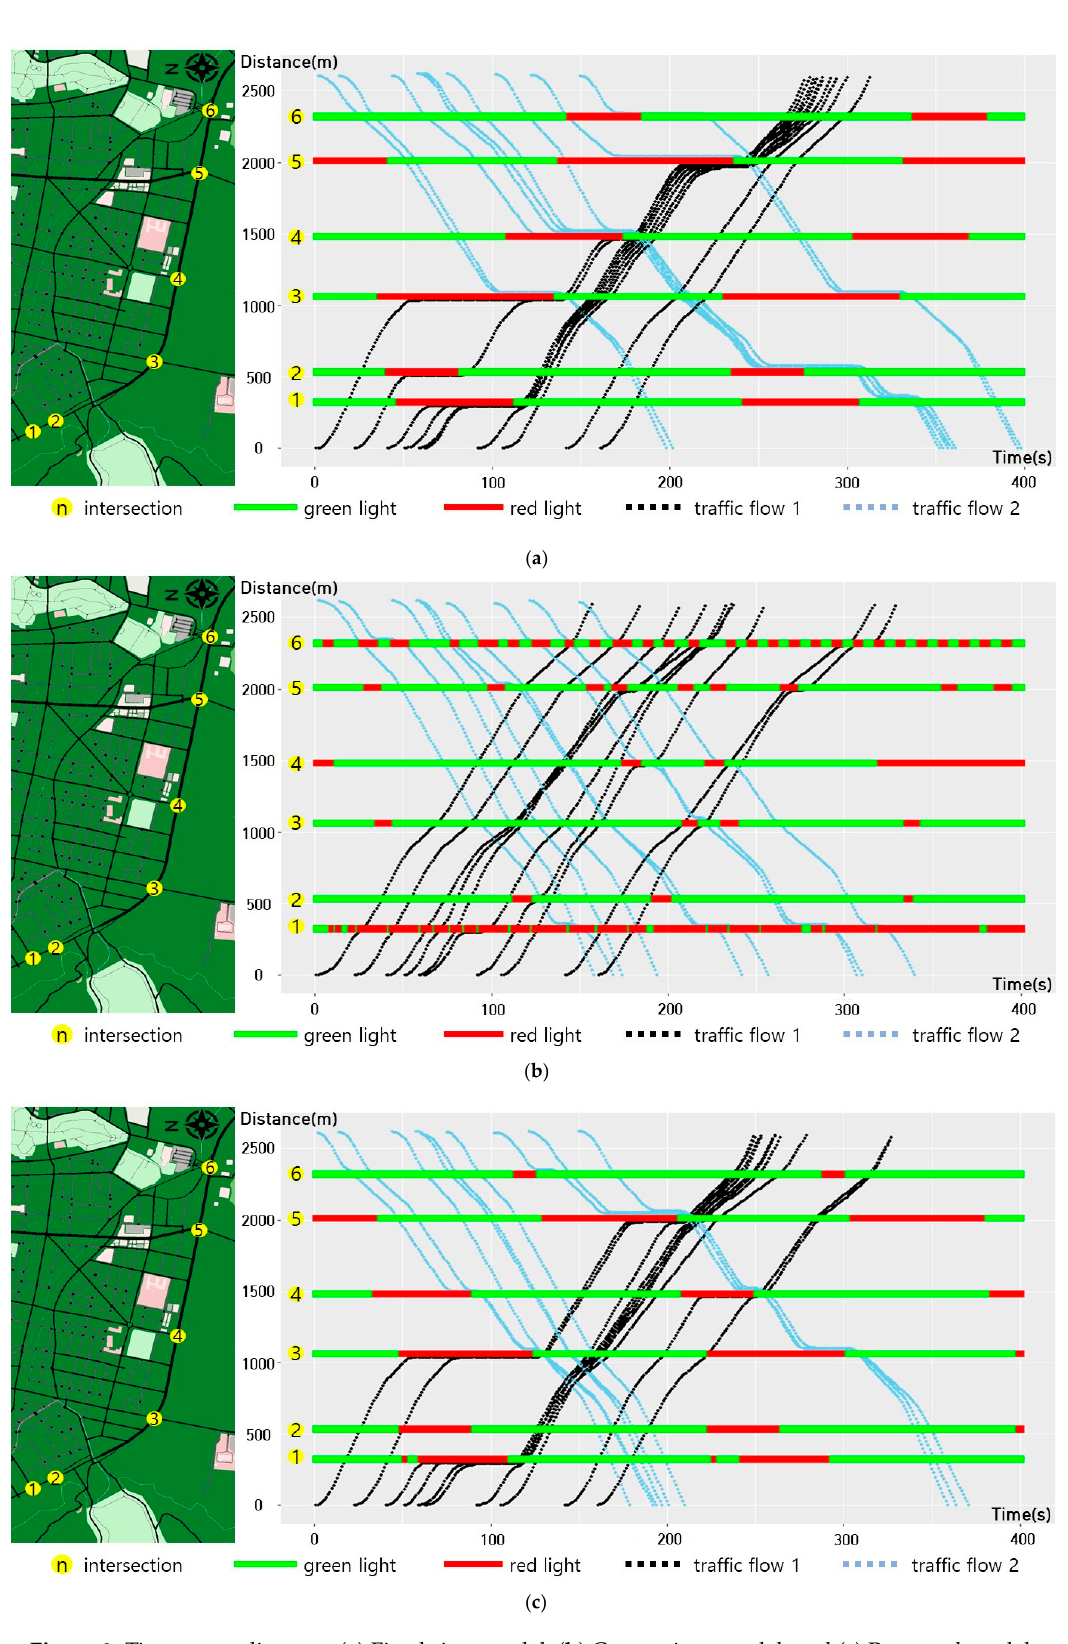
Figure 9. Time-space diagram: ( a ) Fixed-time model; ( b ) Comparison model; and ( c ) Proposed model.